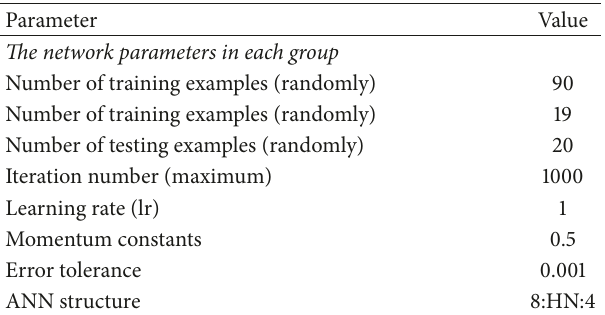
Table 2: The network training parameters. Parameter